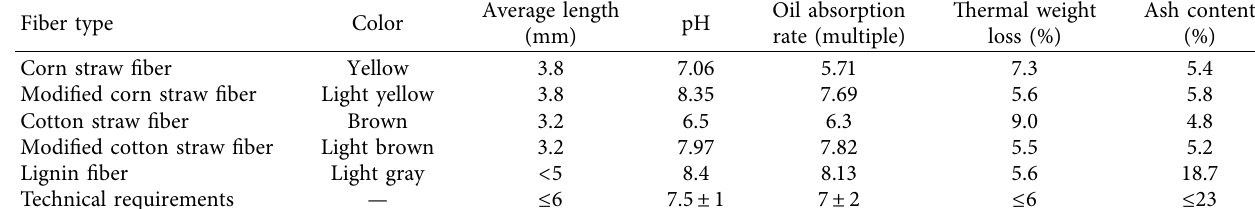
Table 1: Physical properties of